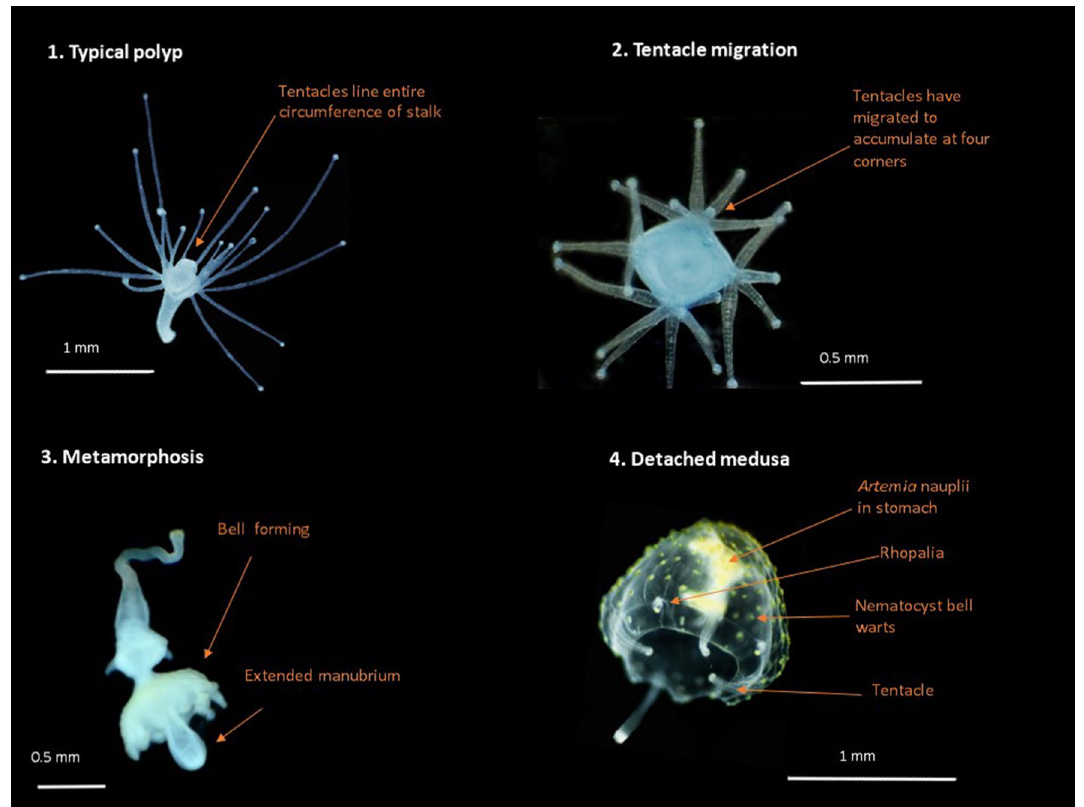
Figure 6. Representative stages observed in metamorphosis of Carukia barnesi polyps. (1) Typical healthy polyp (side view). (2) Polyp exhibiting the first stage of metamorphosis, tentacle migration (dorsal view). (3) Medusa forming on the end of a polyp during metamorphosis. (4) A medusa detached from polyp following metamorphosis. Note tentacles are not fully formed at this immature